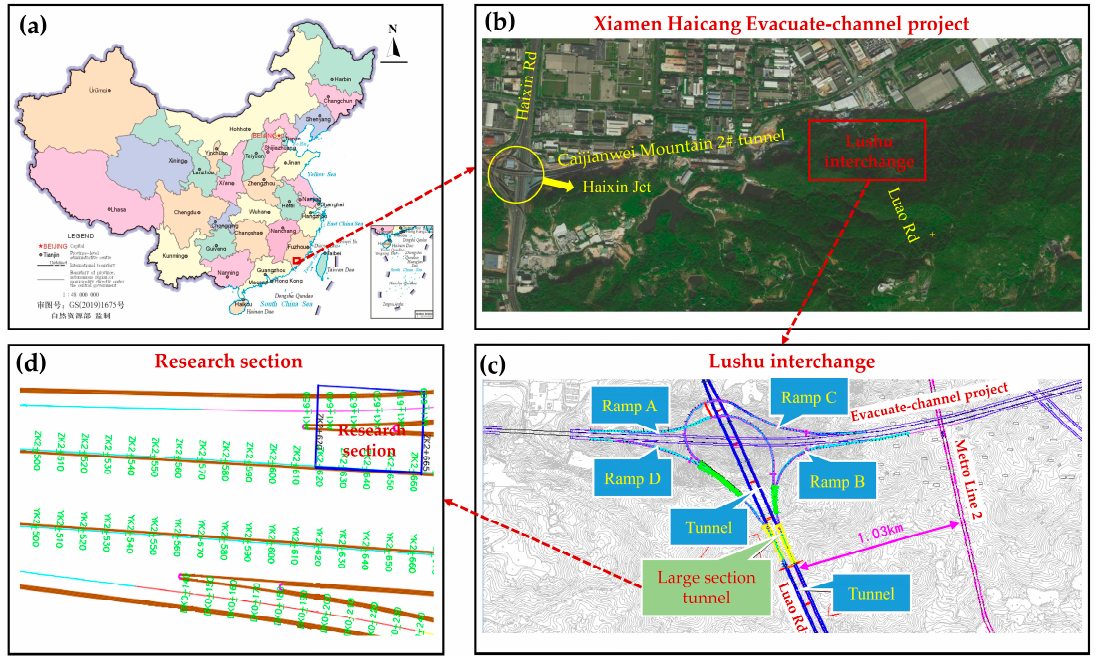
Figure 1. Research section overview: ( a ) Location of Xiamen Haicang; ( b ) Location of Xiamen Haicang Evacuate-channel project; ( c ) Diagram of Lushu interchange; and ( d ) Schematic of research section.